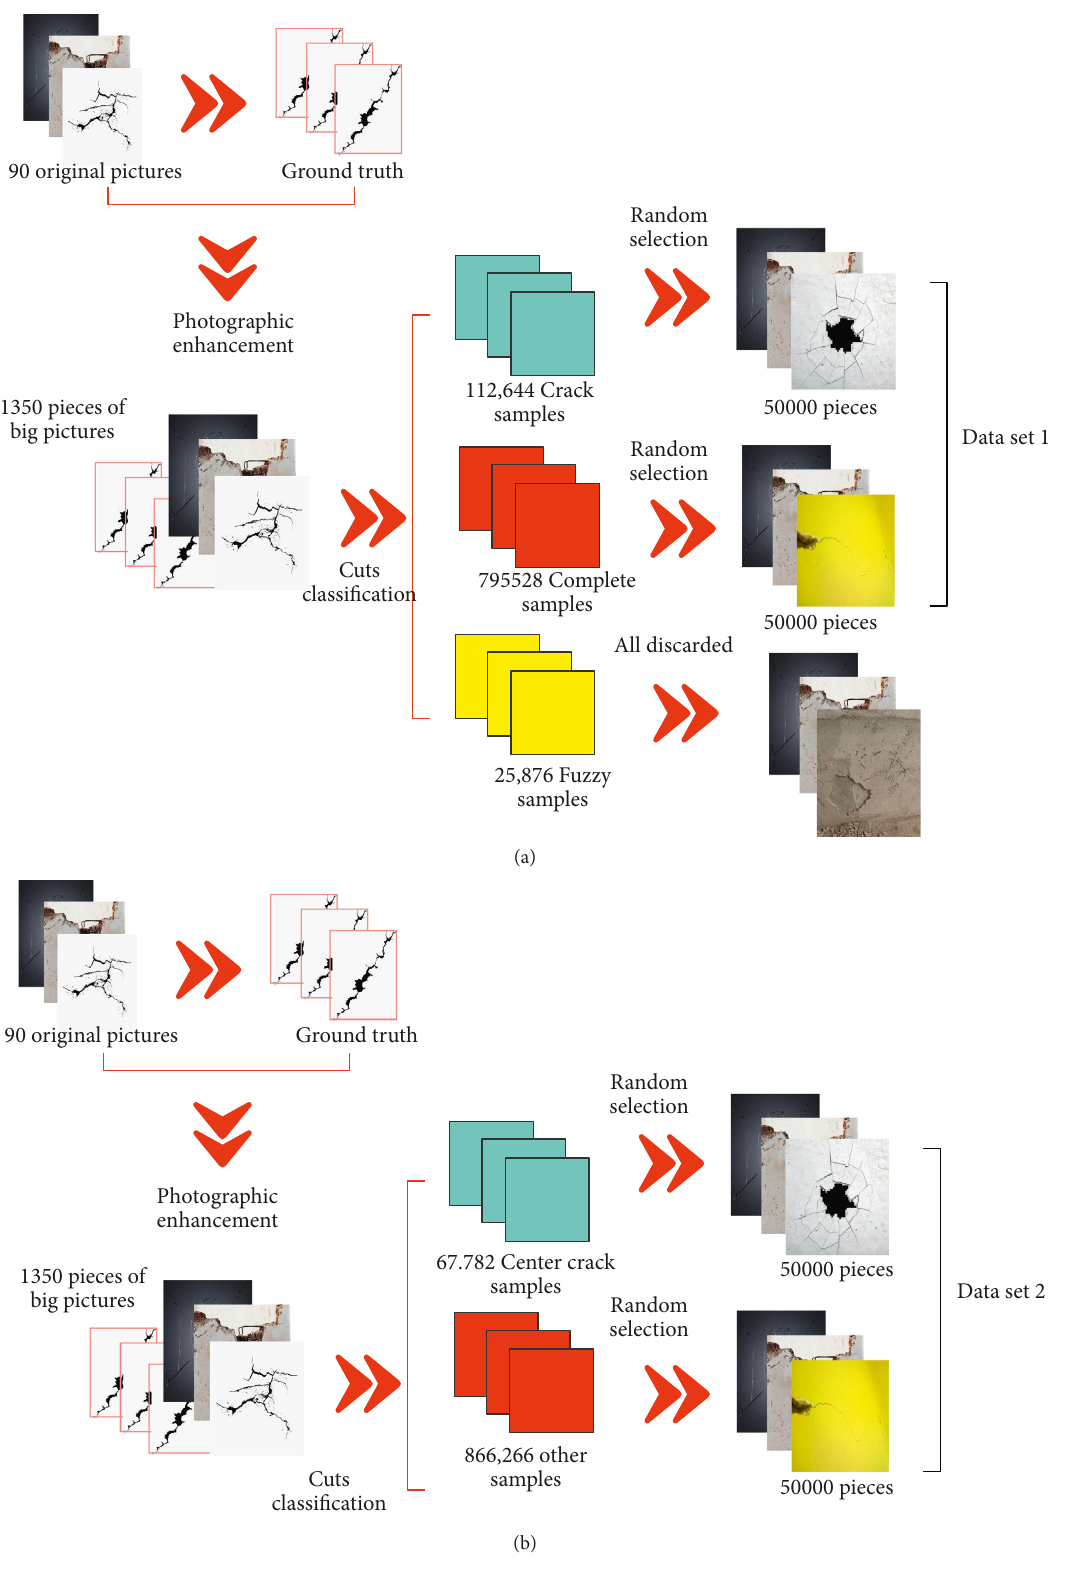
Figure 3: Two classification methods. (a) Dataset 1, (b) Dataset